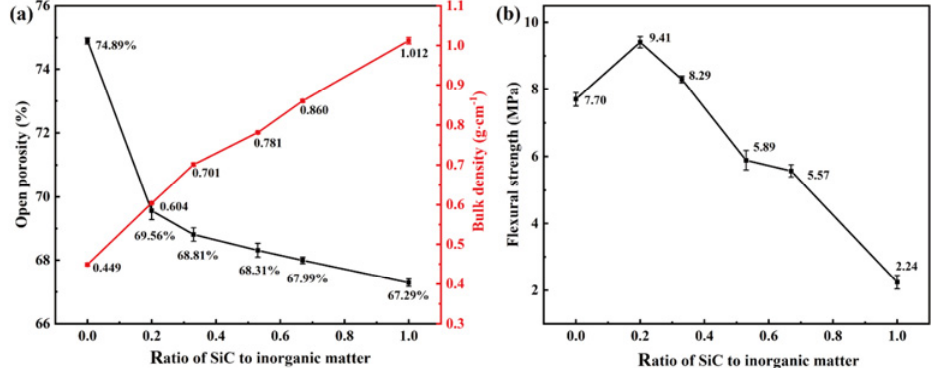
Fig. 9 (a) O and ρ and (b) flexural strengths of C f /SiC/C green bodies with different SiC